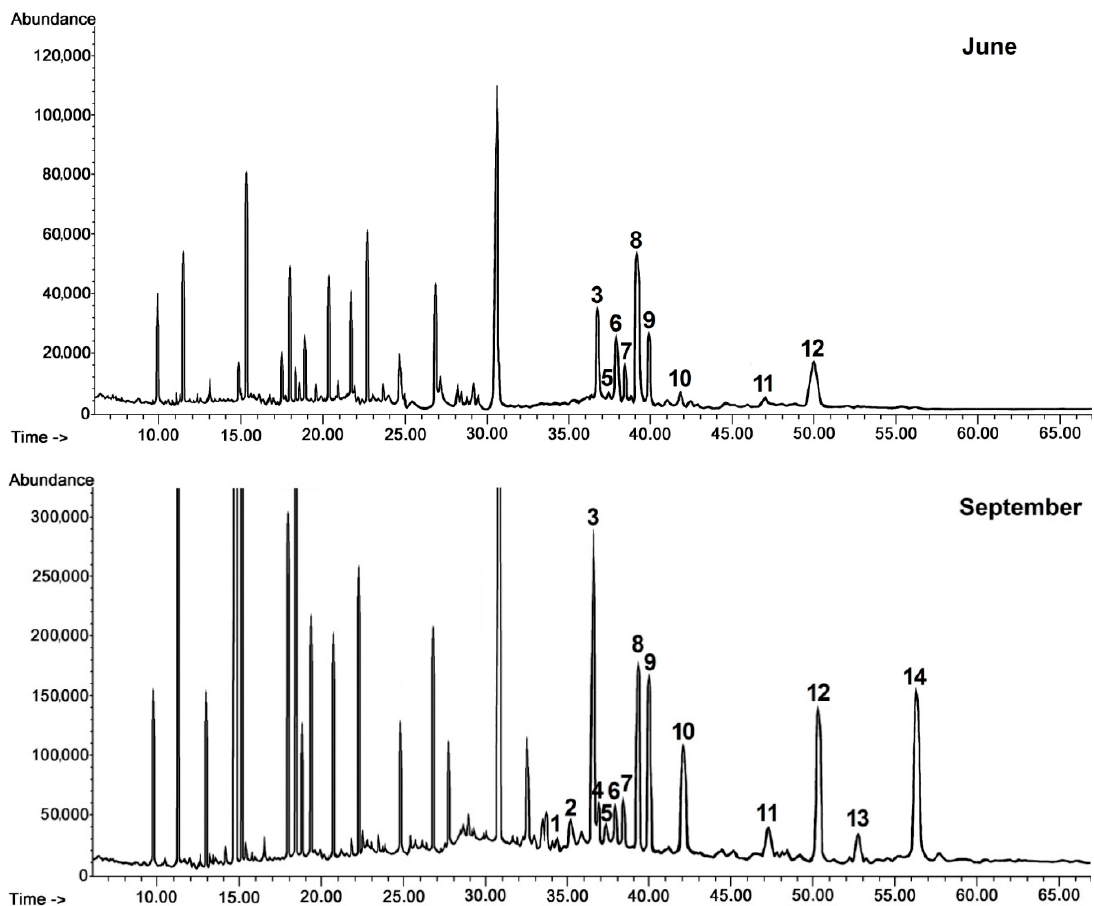
Figure 3. GC-FID chromatograms of the fraction of steroids and neutral triterpenoids obtained from chloroform extracts of cuticular waxes of black chokeberry fruit harvested in two developmental stages (young fruit in June, and ripened fruit in September). 1—campesterol, 2—stigmasterol,